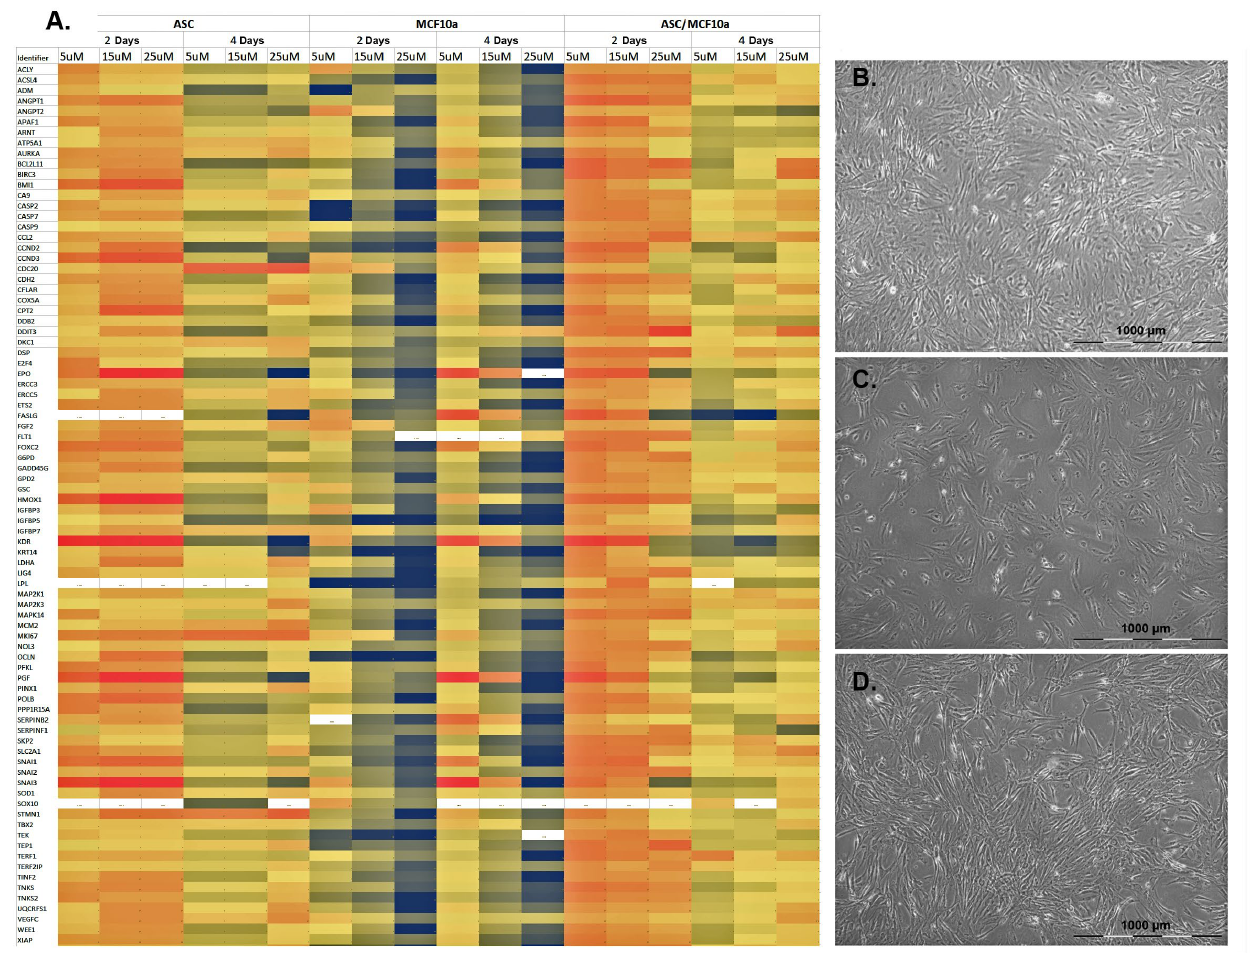
Figure 1. Gene expression of the examined genes of the PCR arrays of ASC, MCF-10A cells and corresponding co-cultures. ( A ) From left to right, ASC, MCF-10A cells and co-culture were each treated with 5 µ g, 15 µ g or 25 µ M tamoxifen for 48 or 96 h. The color-coding (see Figure 2) indicates a relative increase (black) or reduction (red) in gene expression. The 84 genes studied and their associated pathways in tumorigenesis and transformation are listed in Table 1. ( B ) ASC of passage 2 after treatment with 25 μM tamoxifen after 96 h in culture. ( C ) MCF-10A cells of passage 29 after treatment with 25 μM tamoxifen after 96 h in culture. ( D ) Co-culture of ASC and MCF-10A cells after treatment with 25 μM tamoxifen after 96 h in culture.